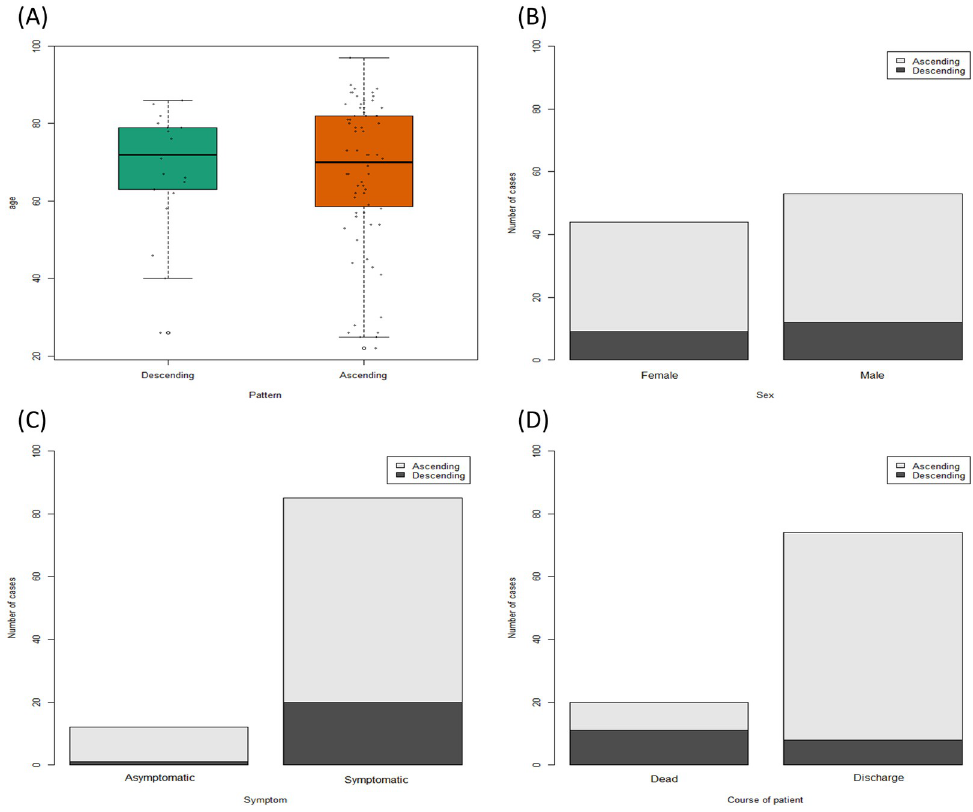
Fig 5. Anti-SARS-CoV-2 antibody pattern across consecutive samples. (A) Ages of patients with the ascending and descending patterns. (B) Ascending pattern according to sex, (C) presence of symptoms, and (D) disease course.